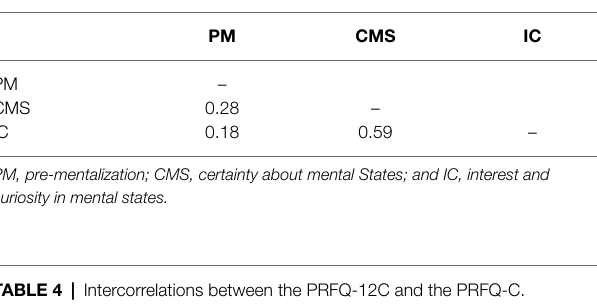
TABLE 3 | Test of discriminant validity for the three-factor of the PRFQ-12C.